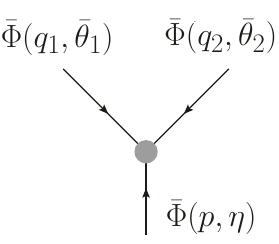
Figure 12 . Antichiral vertex function